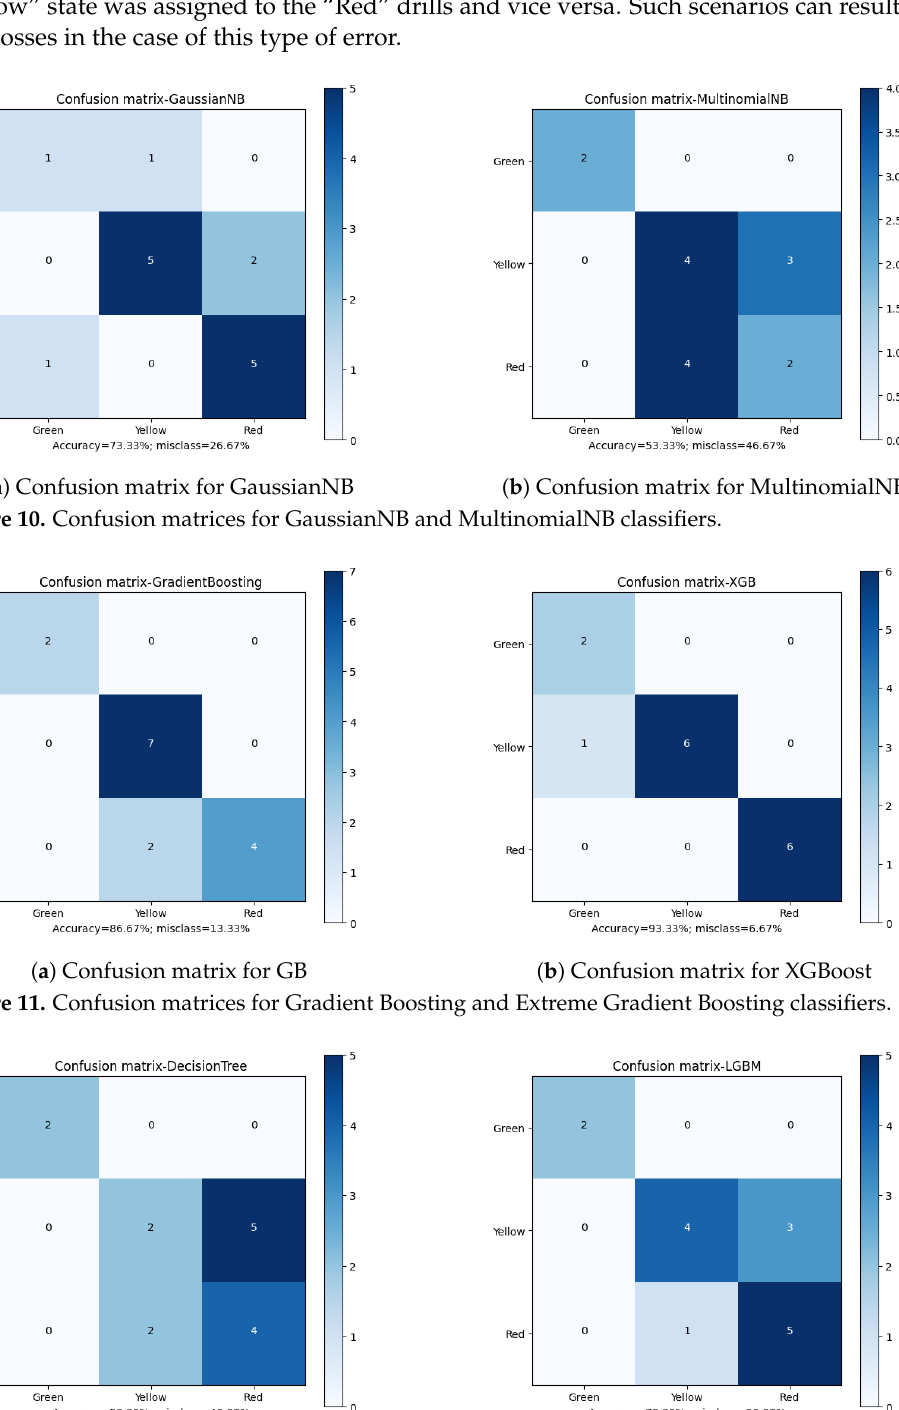
Figure 12. Confusion matrices for Decision Tree and Light Gradient Boosting